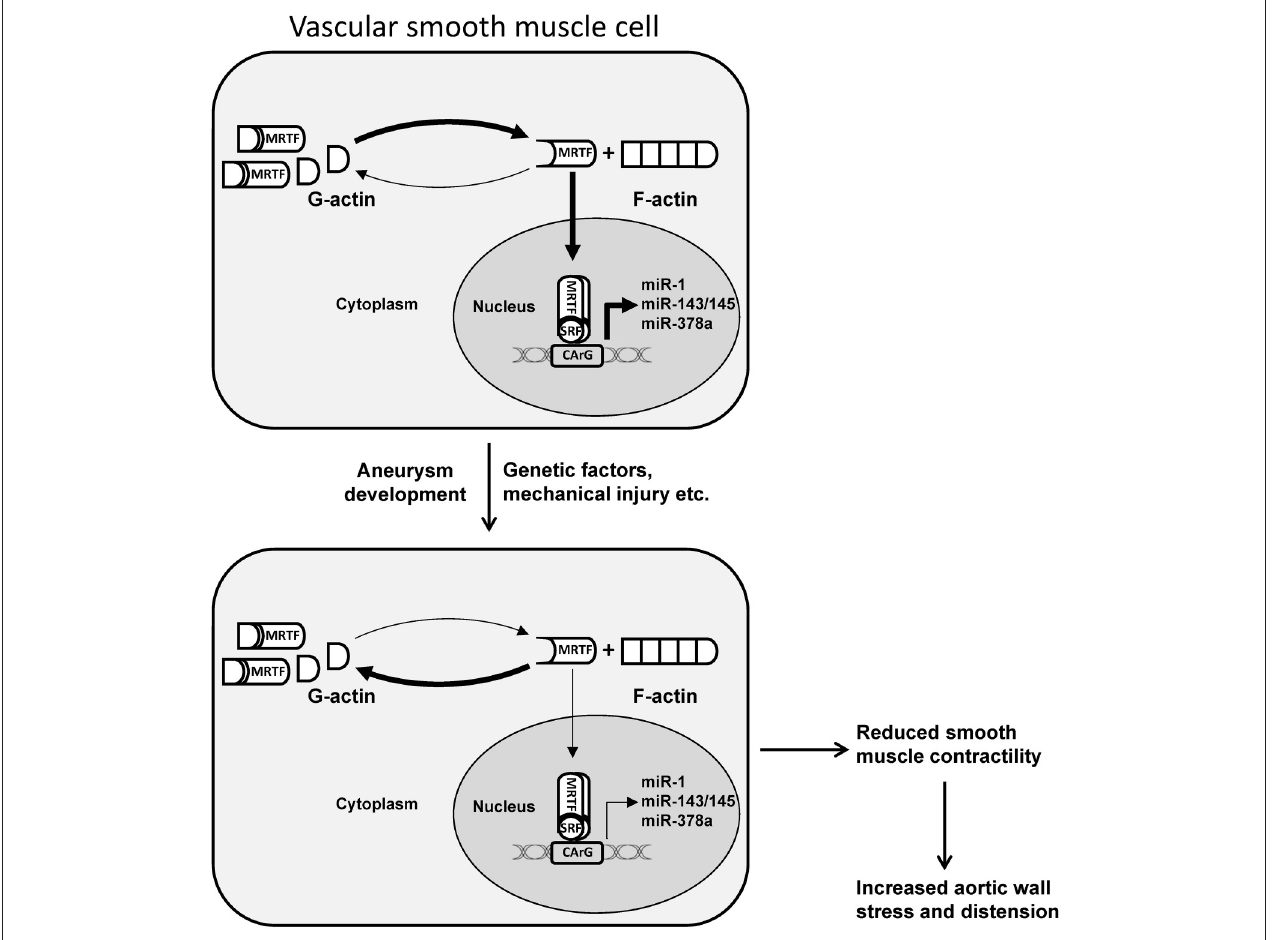
FIGURE 1 | Schematic illustration of MRTF-dependent transcriptional regulation of miRNAs in dilated aorta . An increase in cytosolic or nuclear G-actin due to mutations in actin, mechanical injury, or other factors involved in aneurysm formation, results in decreased nuclear accumulation of MRTF and reduced transcription of miRNAs associated with contractile smooth muscle cells. In addition to other mechanisms, this can result in reduced smooth muscle contractility and increased aortic wall stress and distension. MRTF, myocardin related transcription factor; SRF, serum response factor. Adapted from Alajbegovic et al. (2016).